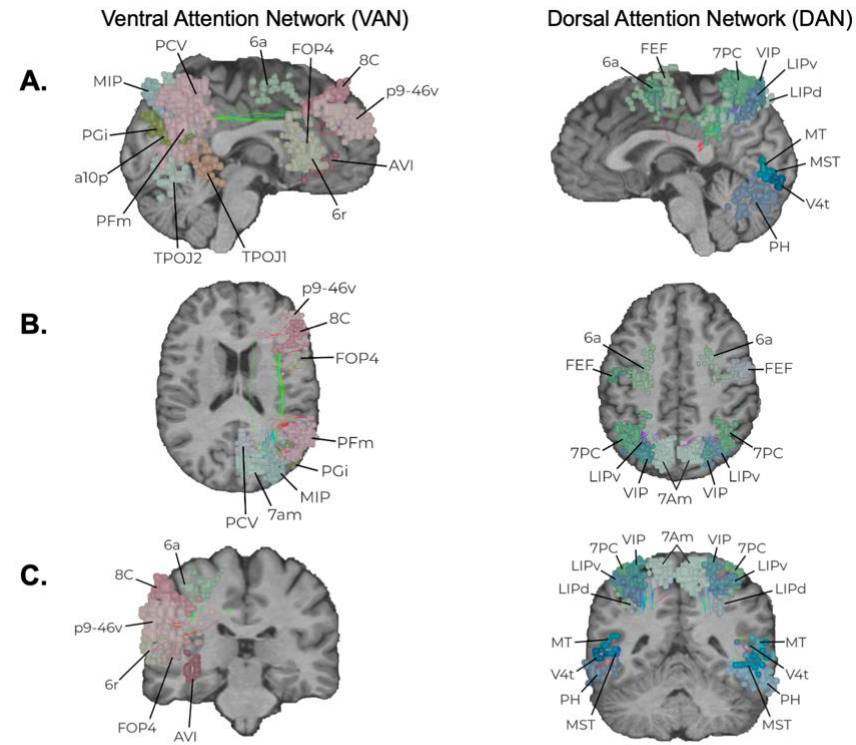
Figure 4. Attention Networks. The anatomic locations of the Dorsal Attention Network (DAN) and Ventral Attention Network (VAN) are presented in sagittal ( A ), axial ( B ), and coronal slices ( C ). Individual parcellations are indicated according to the established Glasser Parcellation Scheme of the Human Connectome Project [24] based on network affiliation